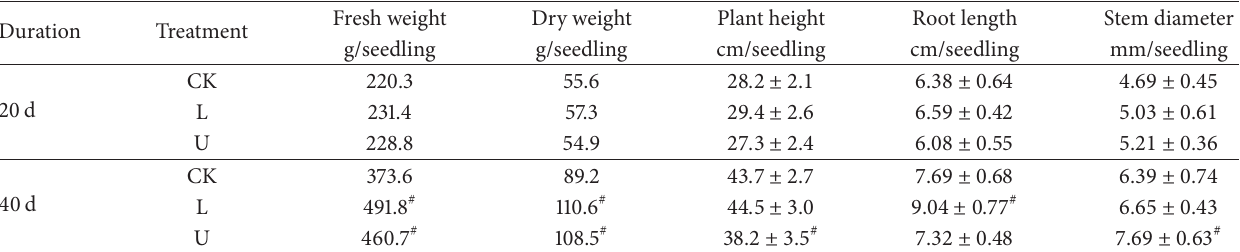
Table 2: Effects of red LEDs and UV-B on the growth parameter of the mung bean. Fresh weight Dry weight Duration Treatment